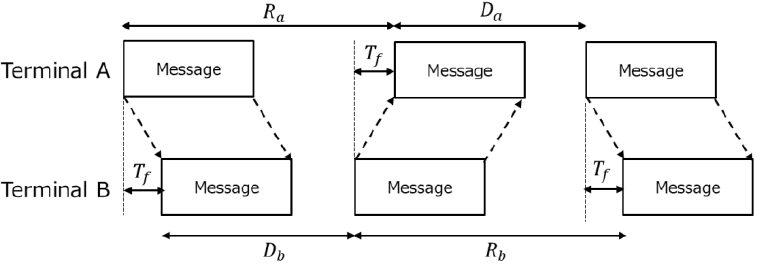
Figure 5. Operation of double-sided two-way ranging with three messages.